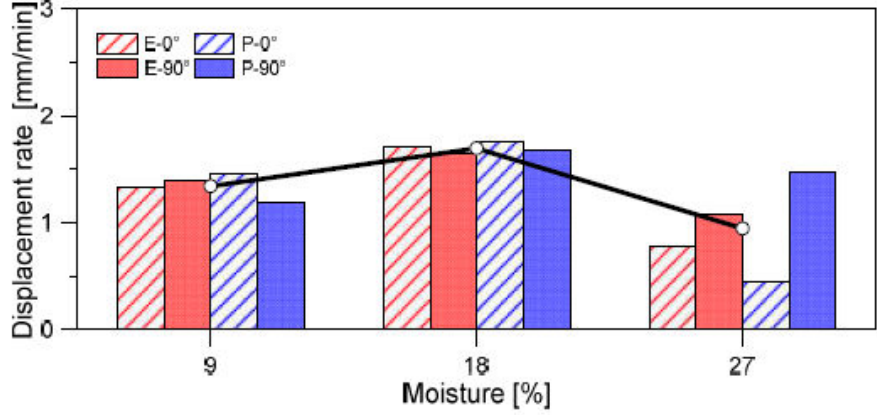
Figure 9. Average experimental displacement rate for the investigated series of